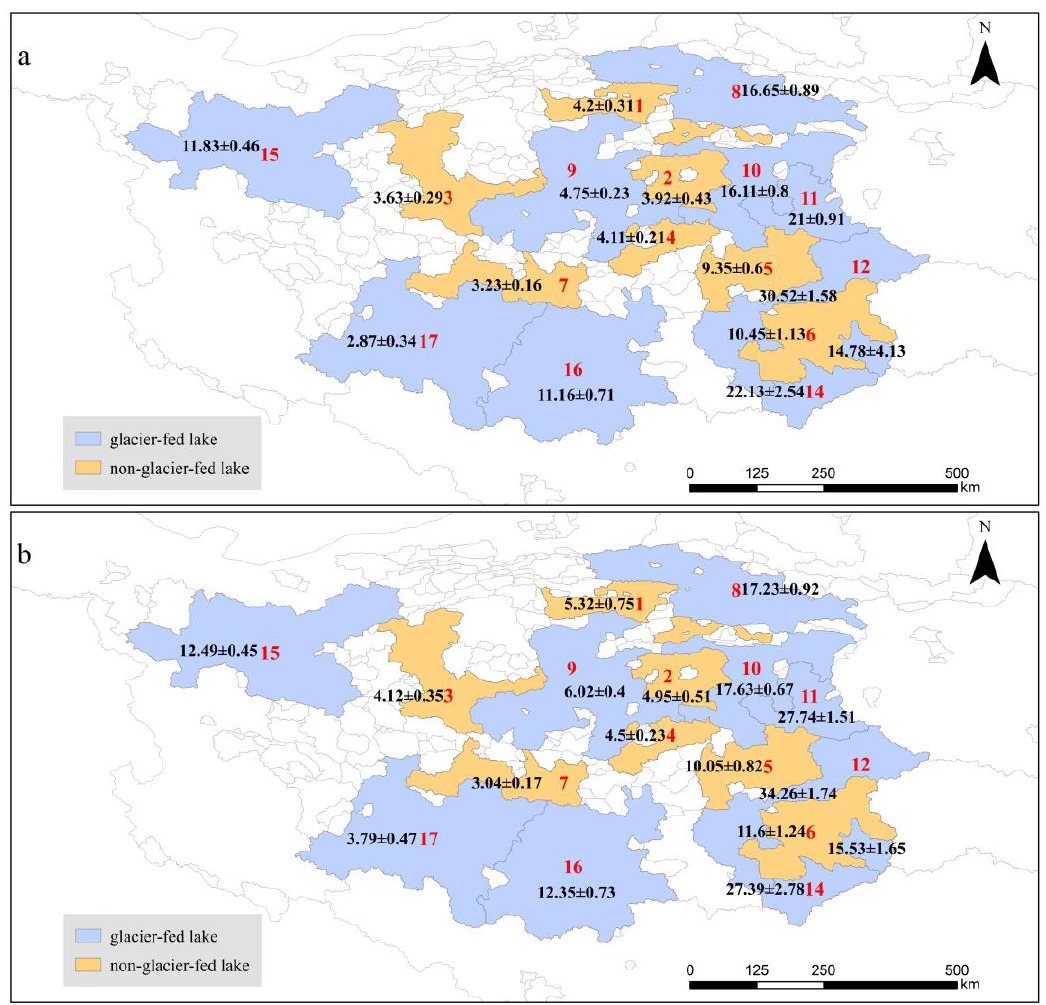
Figure 11. The LWSC per unit area in different regions from 2000 to 2018, regions of 1-7 represent non-glacier-fed lakes basins, regions of 8-17 represent glacier-fed lakes basins. ( a ) The LWSC per unit area of LWSC min ; ( b ) The LWSC per unit area of LWSC max